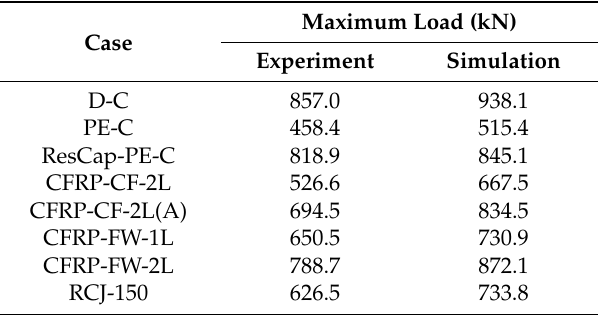
Figure 6. Load-displacement relationships for corbels of the first series. Table 3. Maximum loads for corbels of all